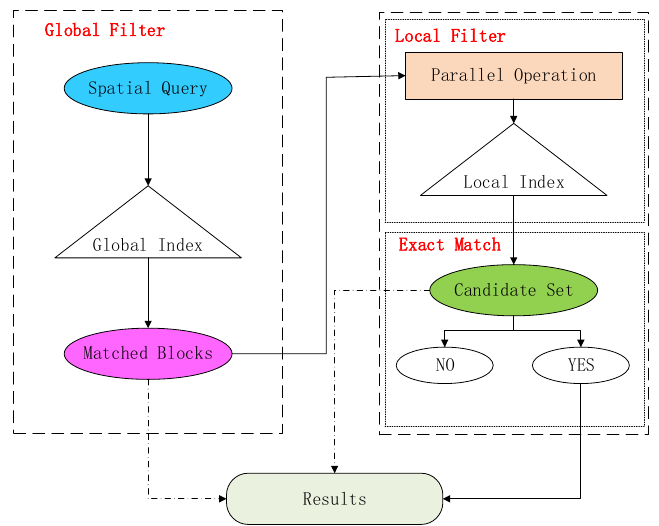
Figure 6. The spatial query steps based on the distributed R-tree index.